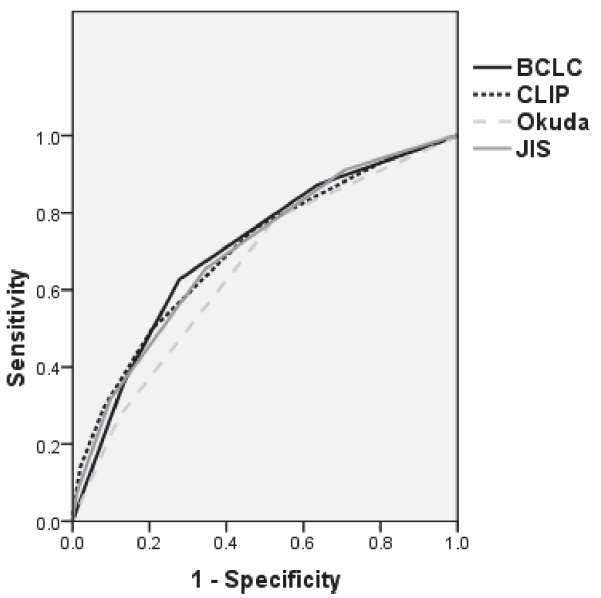
Figure 2. Receiver operating characteristic (ROC) curve for whole cohort. Discriminatory ability for death at one, two, and three years, evaluated by receiver operating characteristic (ROC) curve area, for Okuda, CLIP, BCLC and JIS scores for whole cohort.